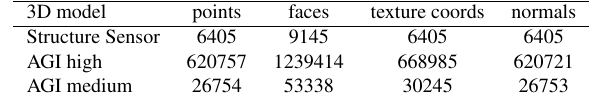
Table 1: 3D models main features. 3D model